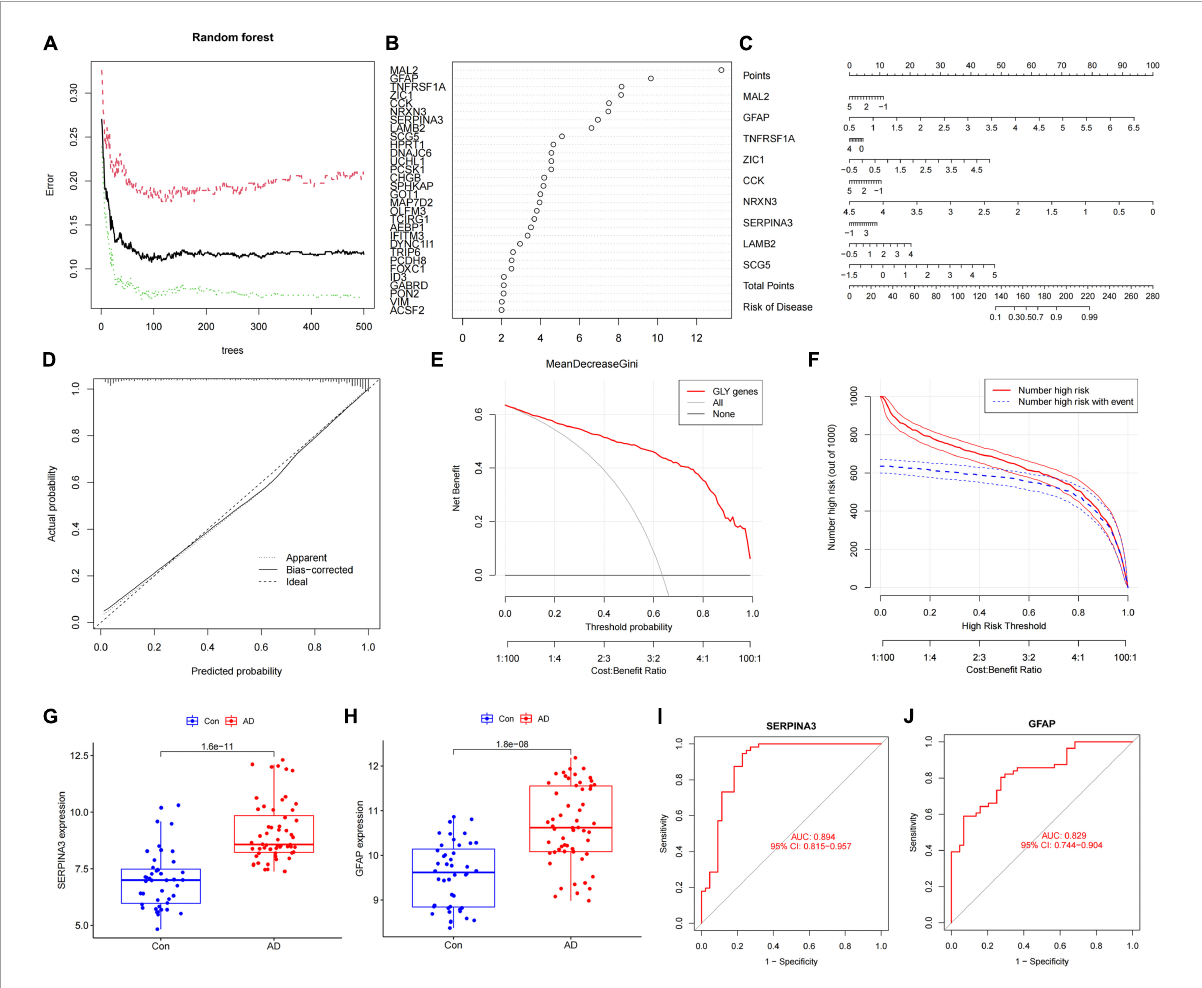
FIGURE4 Construction and verification of the diagnostic line diagram model (A) Random forest trees constructed by cross-validation. (B) Genes with an importance score higher than 2. (C) A line chart was used to predict different protein glycosylation levels in patients with Alzheimer’s disease (AD). (D) A calibration curve that evaluates the predictive ability of the line chart model. (E) The decision curve analysis (DCA) curve was used to evaluate the clinical value of the line chart model. (F) The clinical impact curve of the line chart model constructed based on the DCA curve. (G) The difference in the SERPINA3 gene expression between AD and control samples. (H) The difference in the GFAP gene expression between AD and control samples. (I) Receiver operating characteristic curve of the SERPINA3 gene in the validation set. (J) Receiver operating characteristic curve of the GFAP gene in the validation